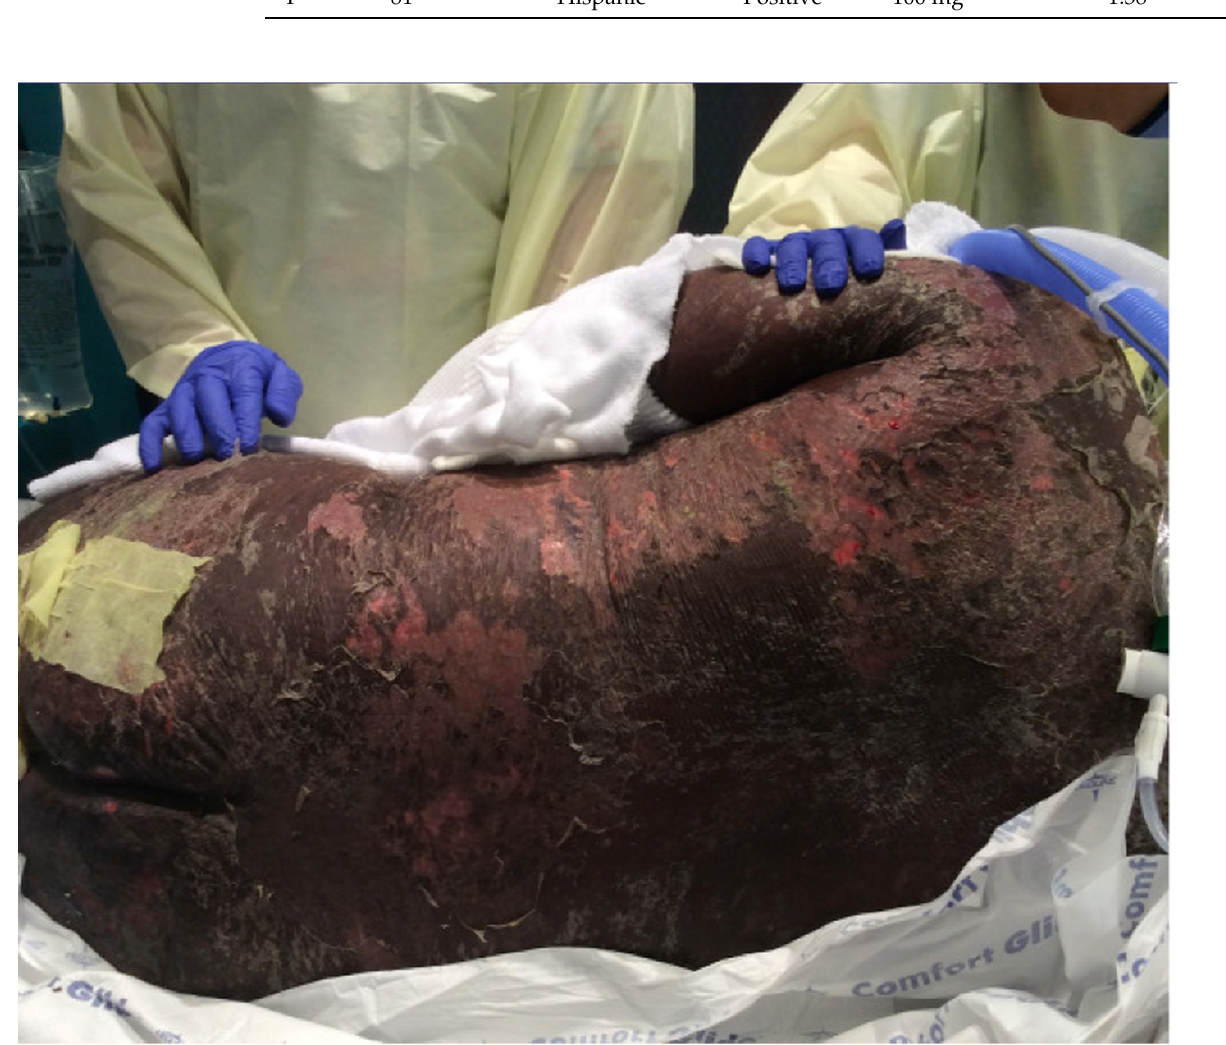
Figure 1. Patient with allopurinol drug-induced hypersensitivity syndrome (DIHS). Erythroderma and epidermal necrolysis with over 80% body surface area (BSA) involvement. Table 1. Case series of allopurinol DIHS. M—male, F—female.